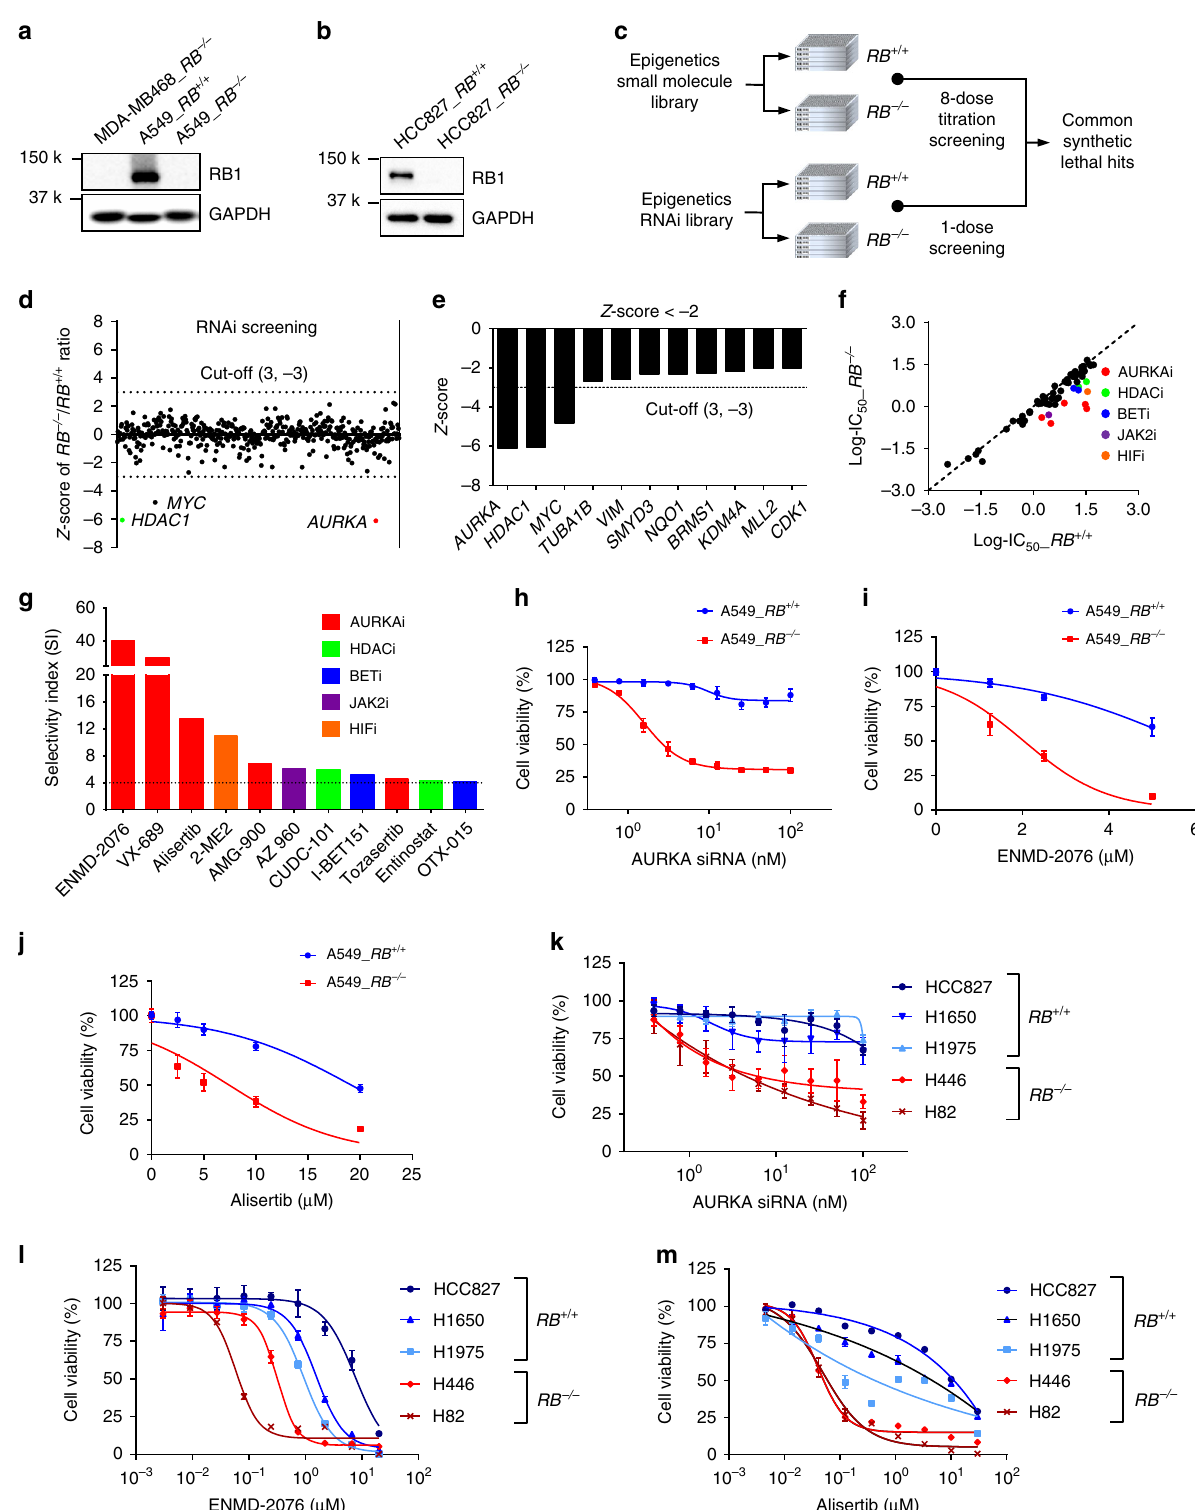
RB1 − / − cells have unbalanced microtubule dynamics . While we were generating RB1-KO lung cancer clones, we have constantly observed that α -tubulin protein level was reduced when RB1 expression was absent or reduced in lung cancer cells (Supple- mentary Fig. 7a). We also observed the same result in mice tumor tissues where α -tubulin level was overall reduced in RB1 − /